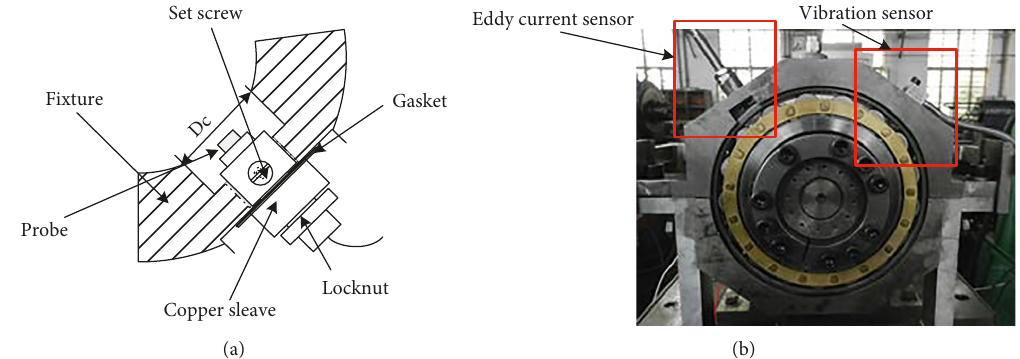
Figure 2: Measurement method: (a) probe unit schematic; (b) inspection